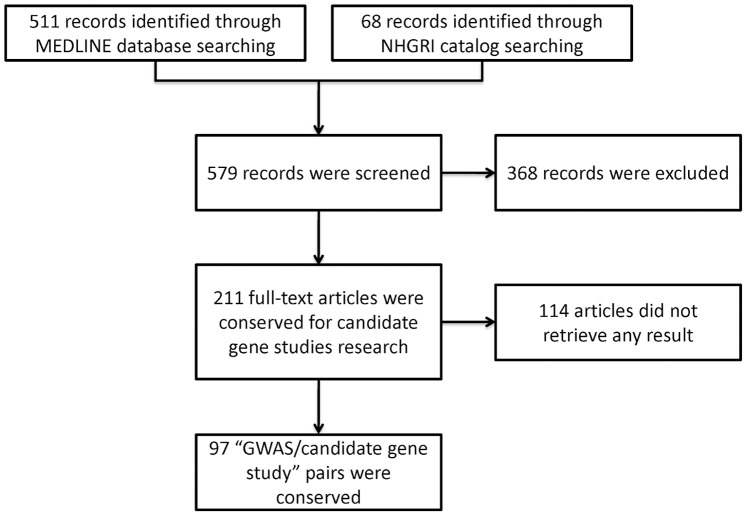
Study flow diagram.